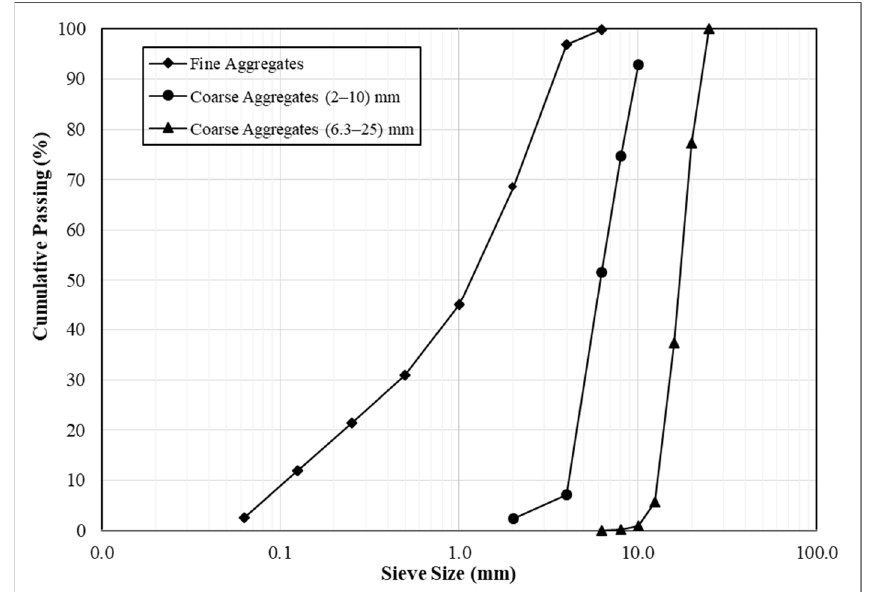
Figure 1. Coarse and fine aggregates’ size distributions. Table 2. Coarse and fine aggregates’ physical